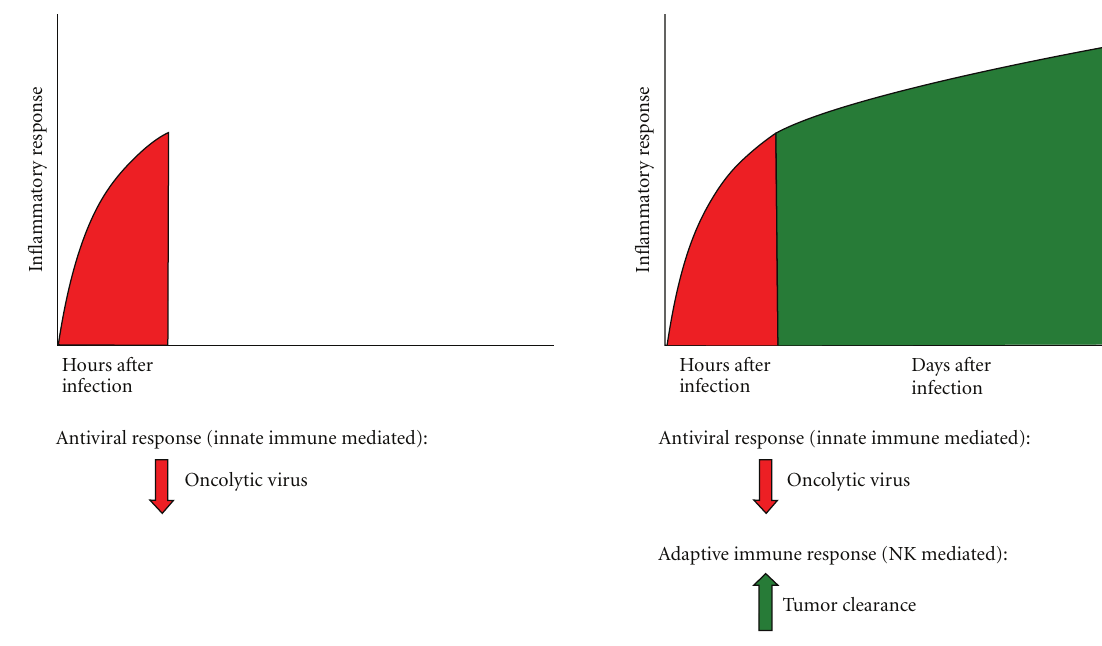
Figure 1: The immune reaction to oncolytic viral infection is two-phased response. Within hours after infection, the innate immune response consisting of NK cells, macrophages, and neutrophils is recruited to the site of infection and mediates initial viral clearance. Following this response to infection, innate immune mediators, particularly NK cells, mediate the downstream adaptive immune response that is a critical antitumor mediator. In order to reconcile this biphasic response, initial immune suppression targeting NK cells may be required initially after viral infection followed by a period of immune stimulation to elicit antitumor